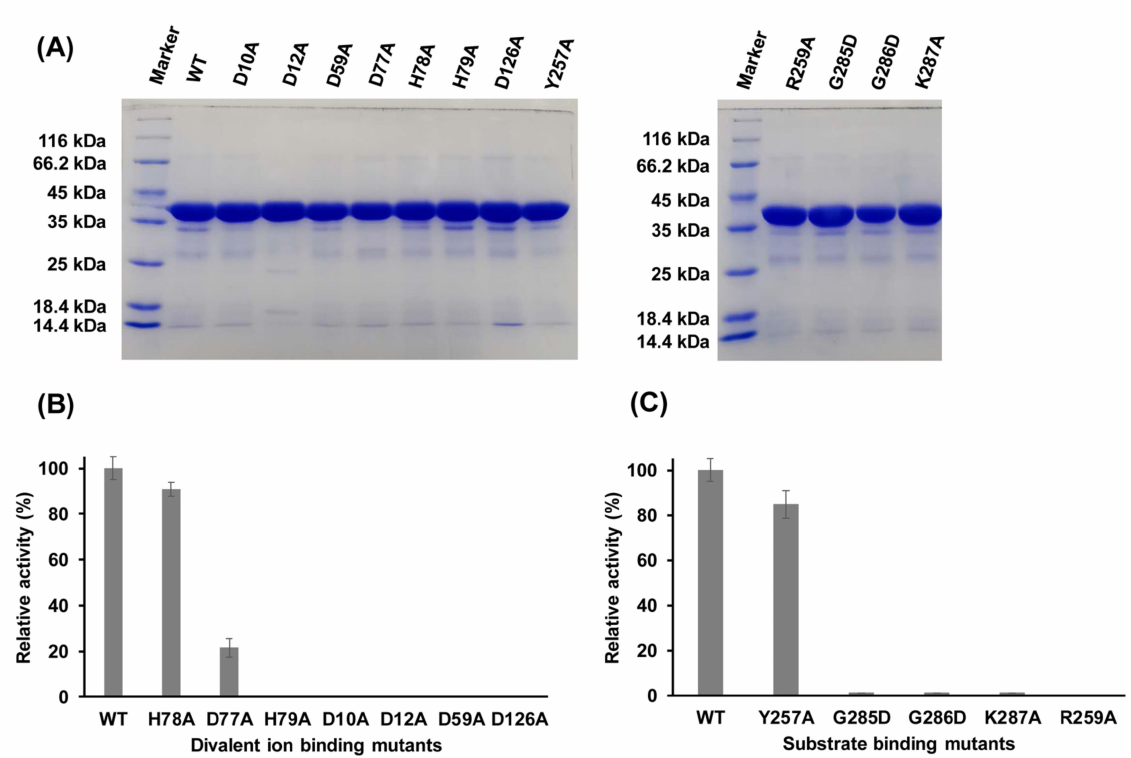
Figure 5. Verification of active sites of PyapApase. ( A ) Purity of wt and mutated pApases confirmed by 12% SDS-PAGE. ( B ) Relative activity of mutants involved in divalent ion binding sites. ( C ) Relative activity of mutants involved in substrate binding. Activities are expressed as percentages of the activity of wild-type pApase. In each reaction, 0.2 mM of pAp was incubated with 3.75 nM of purified proteins at 70 ◦ C for 2